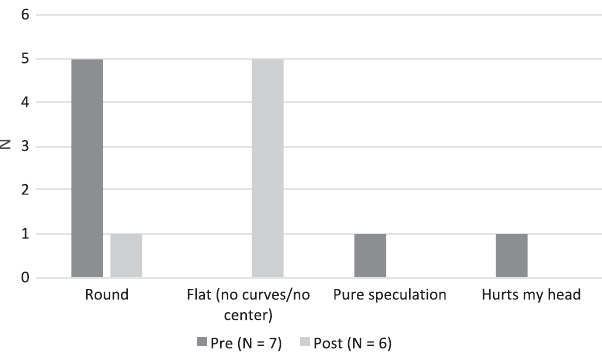
FIG. 11. Shape of the Universe as described by students in